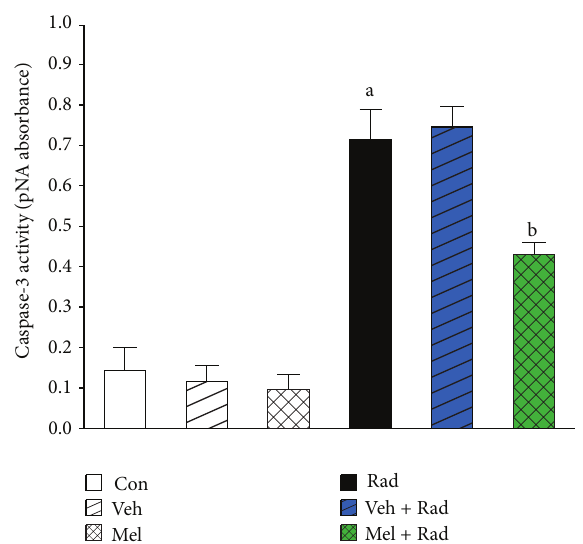
Figure 10: The effect of melatonin on caspase-3 activity in rats subjected to whole body gamma irradiation. Data represent mean ± standard error on the mean (SEM) for 5 animals per group. Con: Control group, Veh: Vehicle only group, Mel: Melatonin only group, Rad: Radiation only group, Veh + Rad: Treated with vehicle and exposed to 10Gy radiation, and Mel + Rad: Treated with 100mg/kg melatonin before exposure to 10Gy radiation. a 𝑃 < 0.001 when compared to Control group. b 𝑃 < 0.001 when compared to the Radiation only